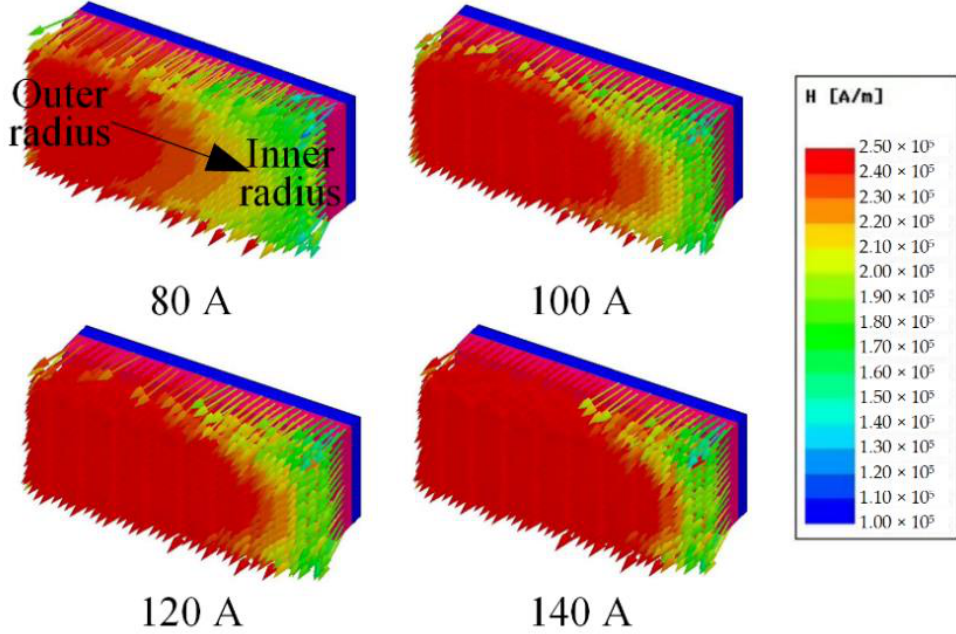
Figure 6. The field distribution inside the SPM under different magnetizing currents.